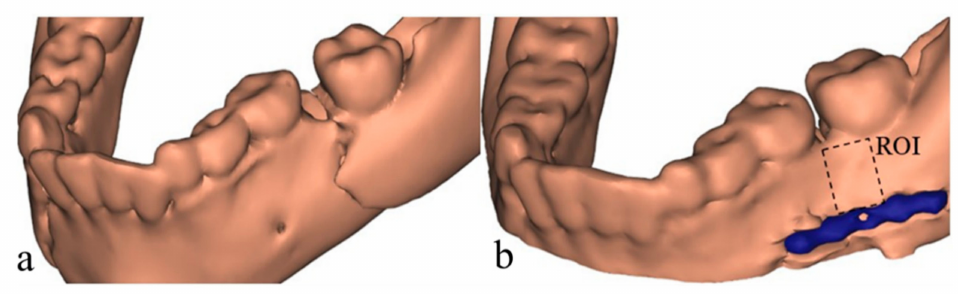
Figure 5. 3D models of the fractured mandible reconstructed using the Mimics software. The left side presents the model created using the CT scans from one day after bone trauma, which were excluded from the analyses due to no visible signs of healing, parts of the mandible are still separated ( a ). The right side presents the model of the mandible with fixing plate created using the CT scans taken 18 days after trauma ( b ). The callus tissue formed in the region of interest (ROI) is observed (the fixing plate is modeled as a dark blue part under the